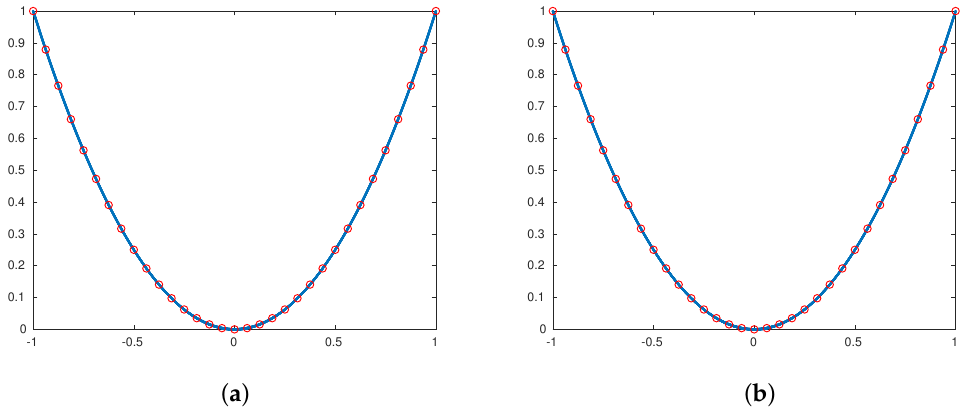
Figure 8. The limit functions in 1d using five subdivision scales; the results shown in ( a , b ) were obtained by S 2 (11), where w = − 1 and S 3 (13), where w = − 4 original sampling is represented in ◦